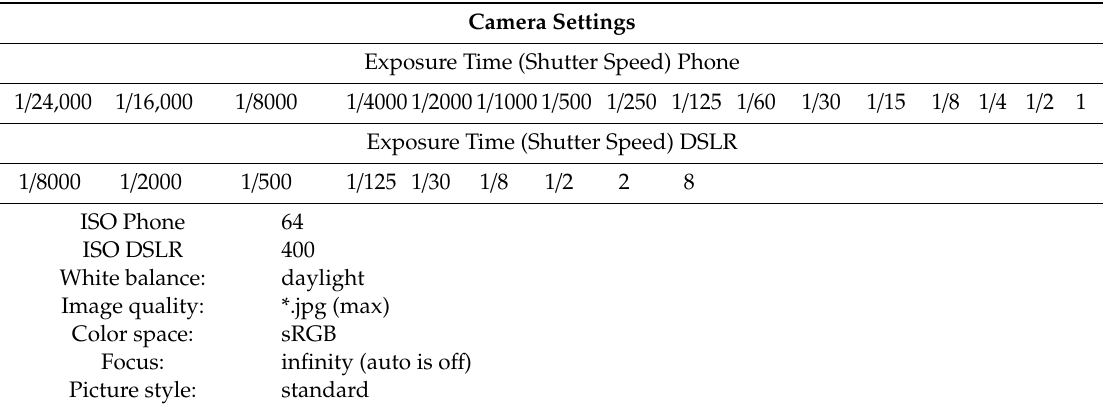
Table 1. Summary of camera settings for both devices.